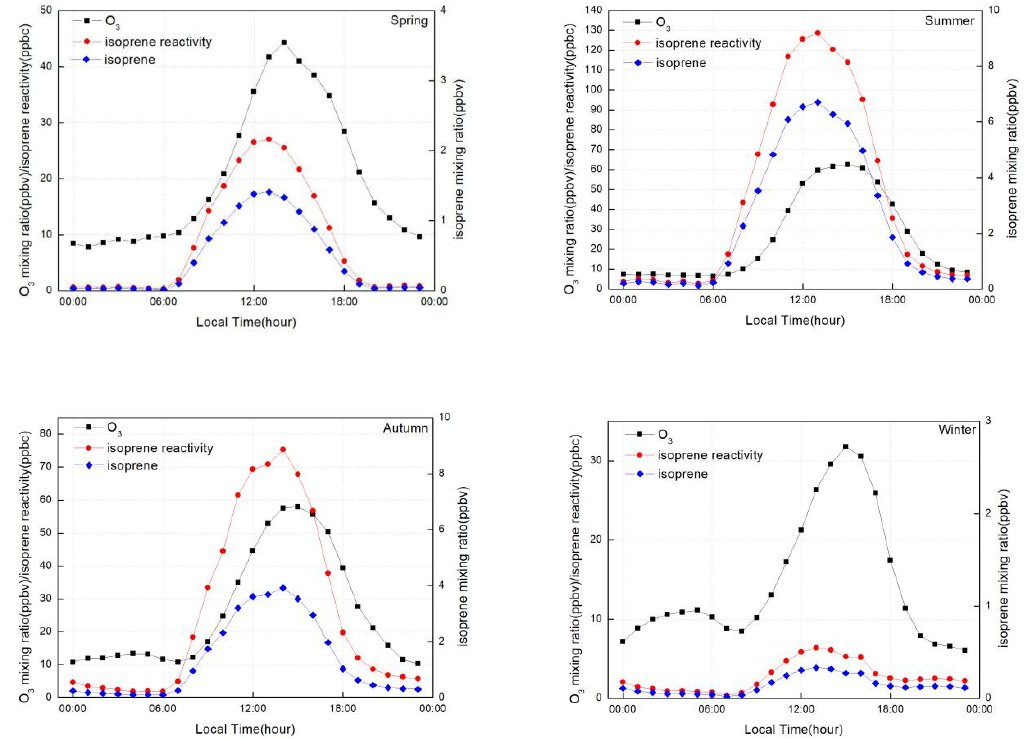
Figure 8. Diurnal variations of isoprene mixing ratios and its reactivities, as well as O 3 mixing ratios in each season from June 2011 to May 2012 at GPACS.